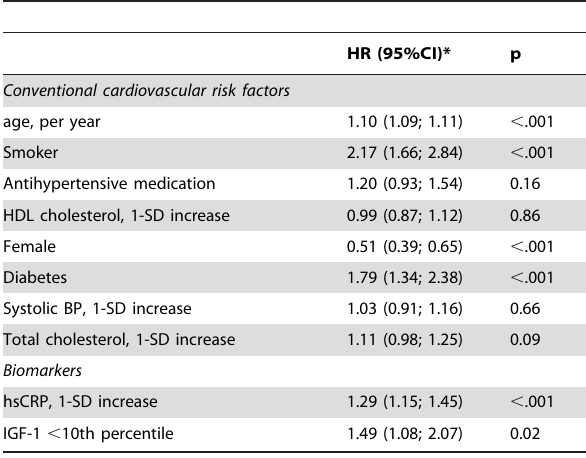
Table 5. Prediction of all-cause death by backward- elimination.